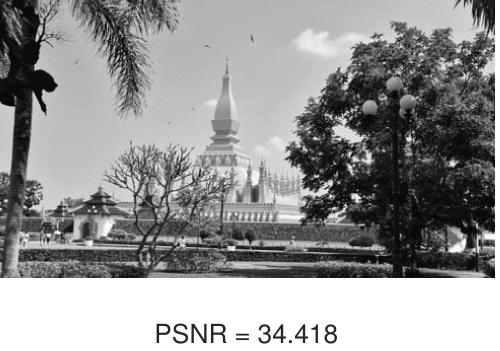
Figure 28. The reconstructed grey image from the blurring operators A 1 , A 2 , and A 3 using the proposed algorithm presented in 10,000 iterations, respectively.